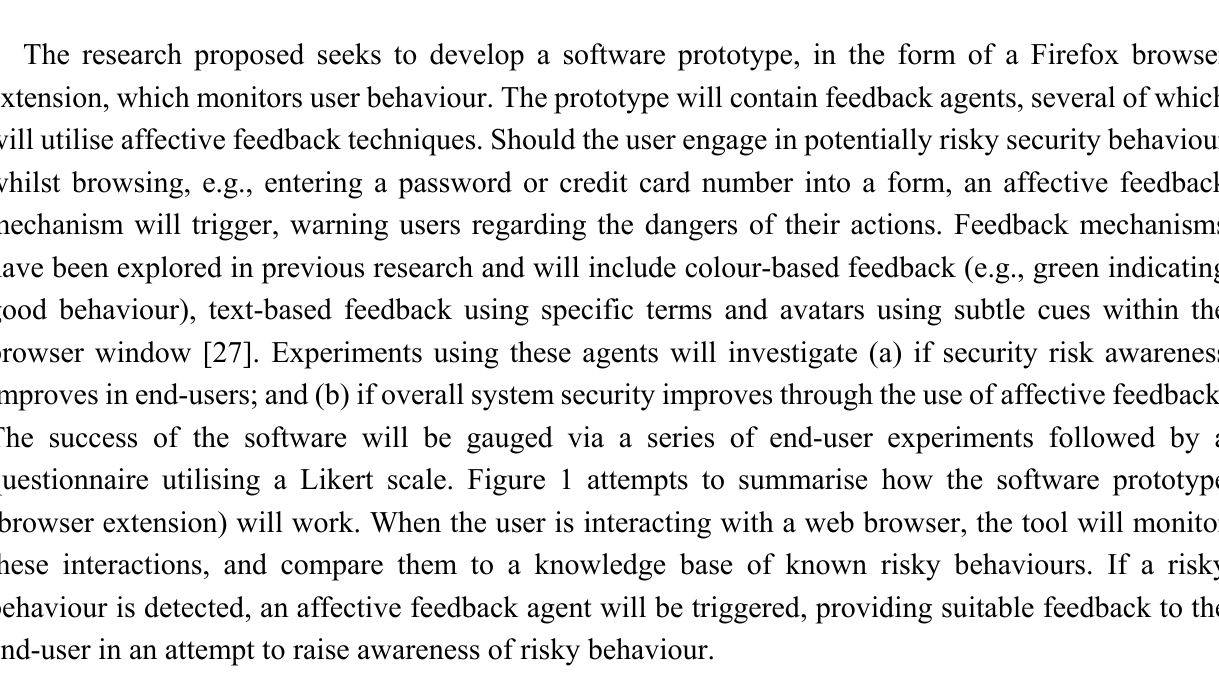
Figure 1. Overview of system